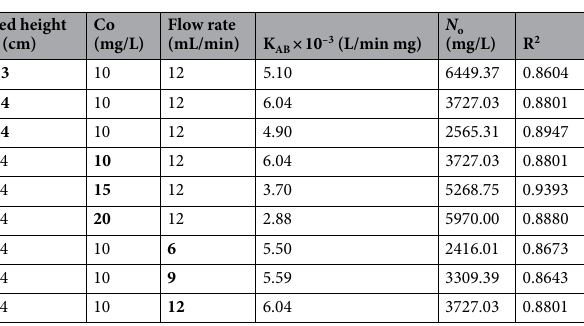
Bed height Z (cm)